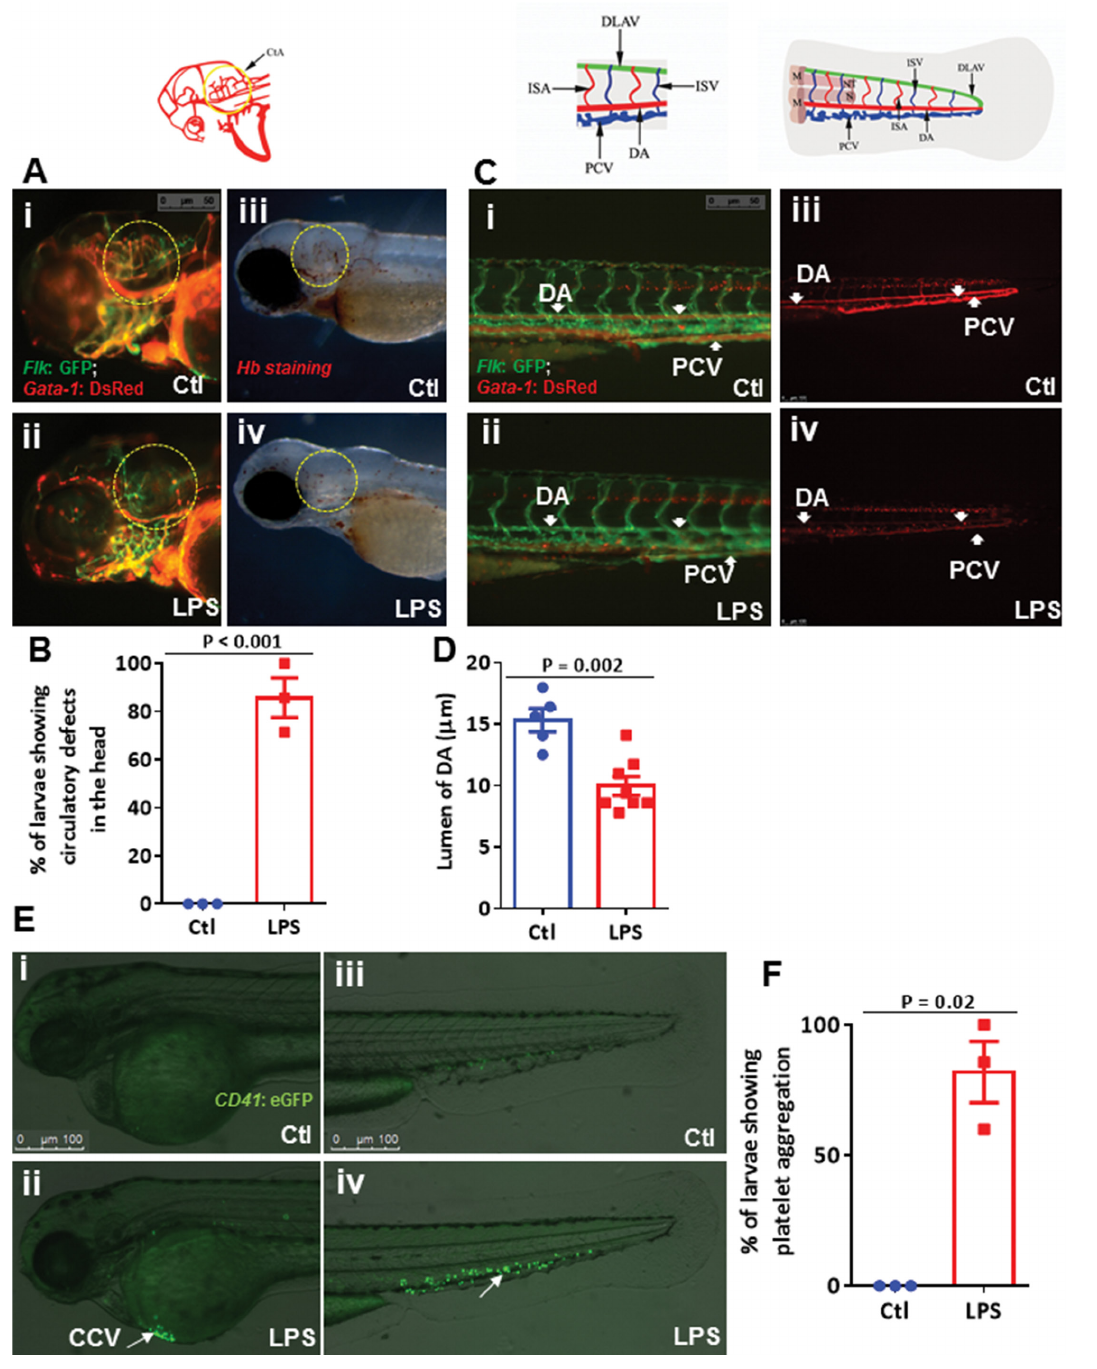
Figure 6. LPS induces blood flow abnormalities in endotoxemic fish. (A, B) LPS exposure in 3 DPF zebrafish larvae leads to marked changes in the microcirculation, characterized by reduced blood flow through the central arteries of the head (as observed through the use of transgenic zebrafish lines and Hb staining; an average of 3 trials with 7 larvae/treatment), microconstriction of the DA (n = 5–8/treatment) and (C, D) reduced circulation through the DA and PCV. (E, F) LPS-treated larvae also show an increased aggrega- tion of thrombocytes in the CCV and major blood vessels, namely DA and PCV (an average of 3 trials with 5–7 larvae/treatment) CtA: central arteries; DLAV: dorsal longitudinal anastomotic vessel; ISA: intersegmental artery; ISV: intersegmental vein; PCV: posterior cardinal vein; DA: dorsal aorta; M: muscle; NT: neural tube; N: notochord; CCV: common cardinal